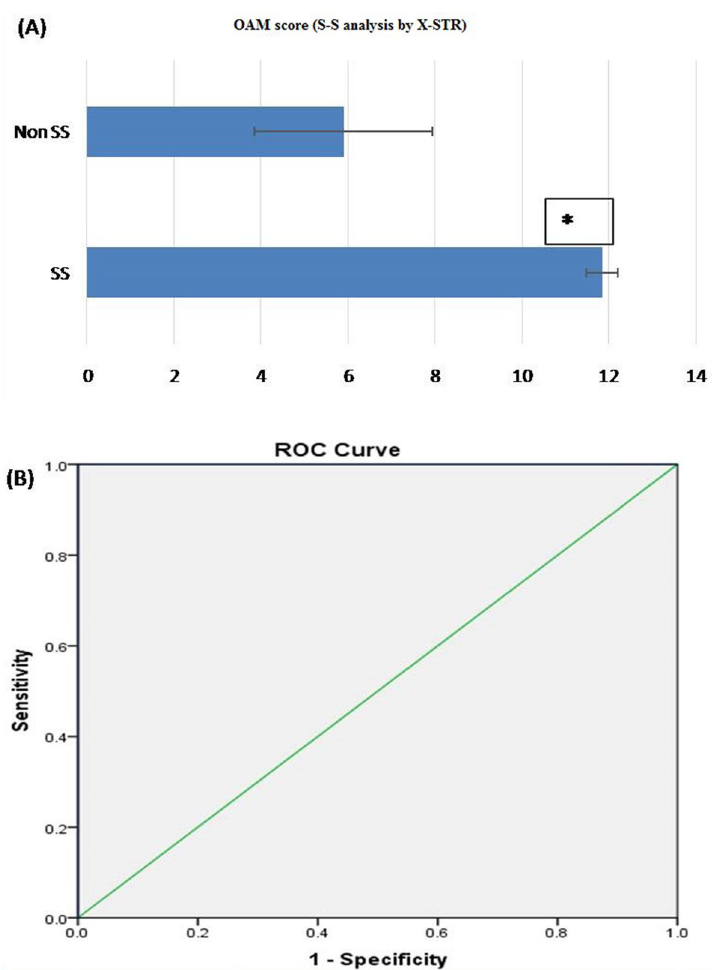
Figure 6. ( A ) OAM score for S–S analysis by X-STR: Based on OAM score, statistically significant difference between S–S (related) and non-S–S (unrelated) groups was seen with X-STR. The Average OAM score for S–S is 11.85 ± 0.366 (SD), whereas, for the non-S–S group, the average OAM is 5.90 ± 2.049 (SD). Figure 6 (A & B) obtained from SPSSsoftware version 22.0 (Available for download at: https:// www. ibm. com/ suppo rt/ pages/ downl oading- ibm- spss- stati stics- 22). *Statistically significant difference (p < 0.05). ( B ) ROC curve (AUC 100%), showing the performance of OAM score as a screening test for S–S pairs by